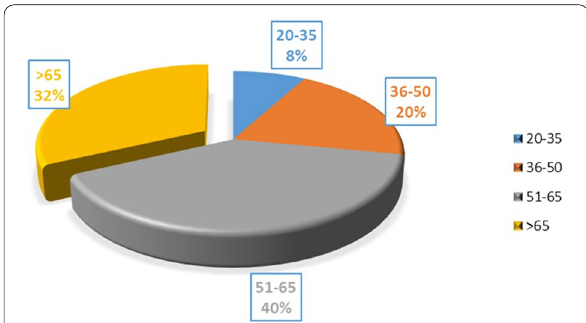
Fig. 1 Distribution of all patients according to age